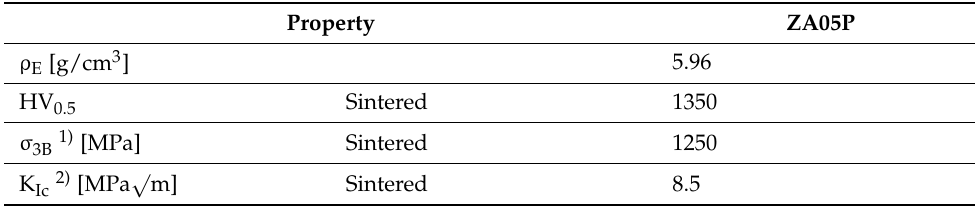
Table 8. Mechanical properties of Y-Ce-TZP/Al 2 O 3 /LaAl 11 O 18 .